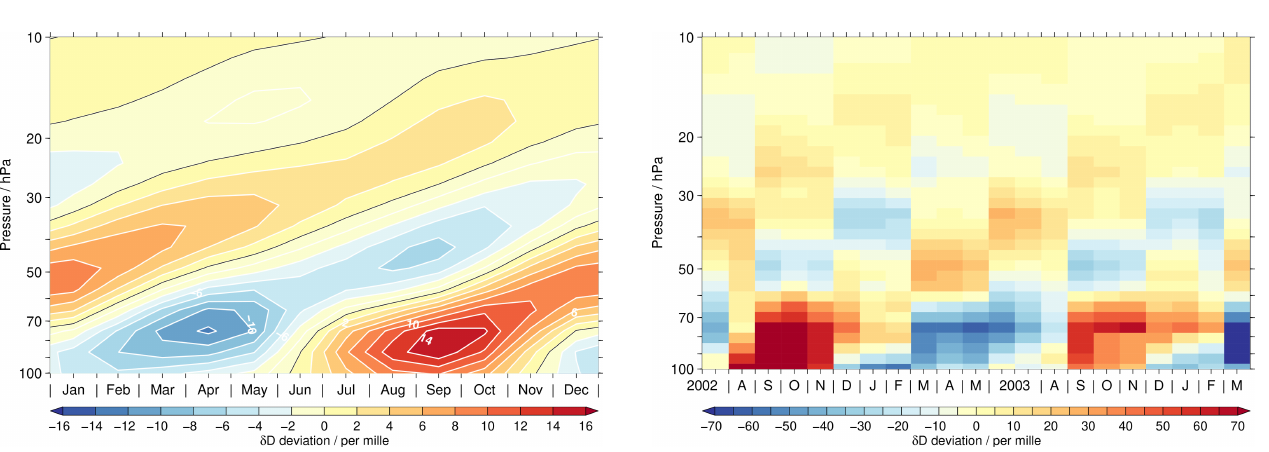
Figure 11. An artificial tape-recorder-like signal in δ D due to dif- ferences in the vertical resolution of the H 2 O and HDO data. The results are based on a simple test using the higher vertically resolved EMAC data for the latitude band between 15 ◦ S and 15 ◦ N. See text for more details.